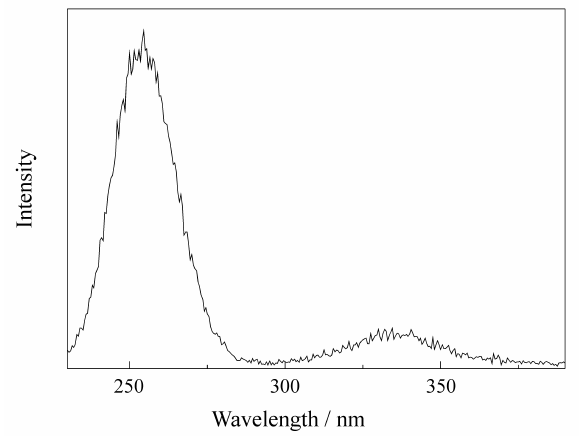
Figure 3. Emission spectrum of the Y 0.85 Eu 0.15 NbO 4 at liquid nitrogen temperature ( l exc = 344 nm).